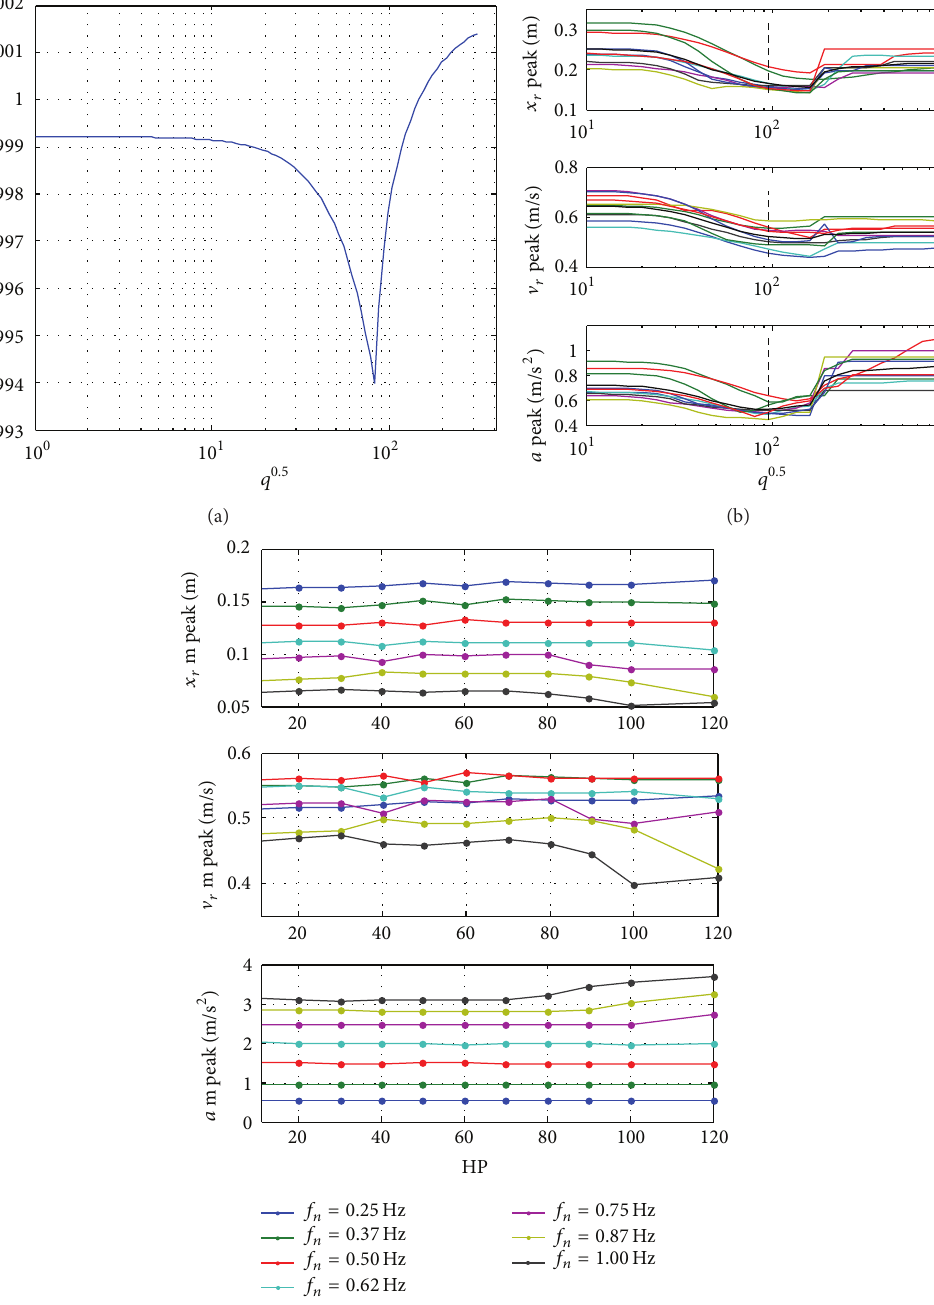
Figure 7: Result for system with 𝑓 𝑛 = 0.25 Hz and 𝜉 = 10 % considering 𝑇 𝑠 = 5 ms, HC = 1 . 𝑟 = 1 and 𝑑 = 10 . (a) System eigenvalues’ moduli (maximum values) evolution with acceleration weight; (b) system responses’ (peak values) evolution with acceleration weight when subjected to type 1 seismic actions; (c) system responses’ (mean peak values) evolution with prediction horizon for different natural frequencies ( 𝑓 𝑛 =